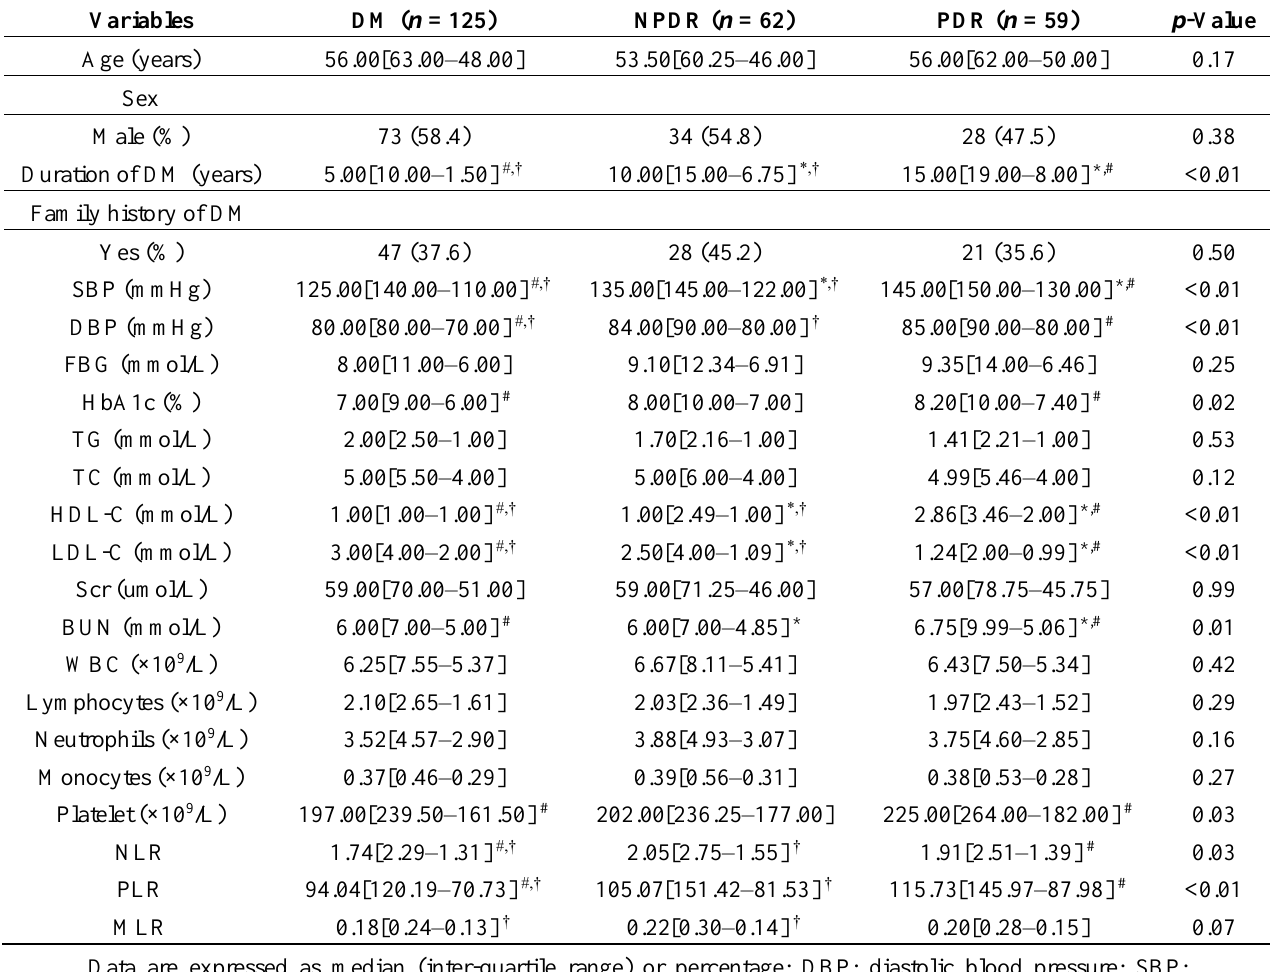
Table 2. Comparison of inflammatory and hematologic parameters in patients with and without retinopathy and its severity.